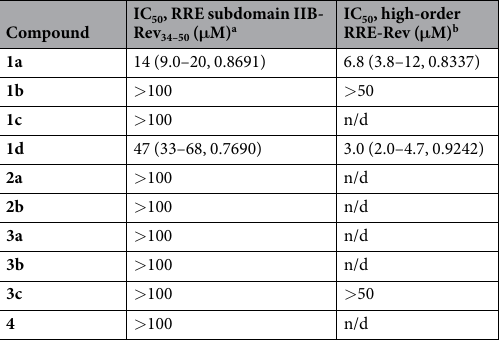
Table 1. 50% inhibitory concentrations of 1,4-terphenyl molecules for RRE subdomain IIB-Rev 34–50 and high- order RRE-Rev complex formation. a RRE subdomain IIB–Rev 34–50 IC 50 values were obtained with fluorescence anisotropy experiments using 60 nM IIB h and 10 nM frevp in the presence of 100 mM KCl, 20 mM NaCl and 2 mM MgCl 2 . b Full-length RRE–Rev IC 50 values were measured by EMSA with 78 nM RRE, 1.32 μ M Rev, 300 mM KCl and 1 mM MgCl 2 , analysing the band corresponding to high-order complexes. The table shows best-fit IC 50 values, with 95% confidence intervals and R 2 coefficients shown in parentheses when applicable. n/d: not